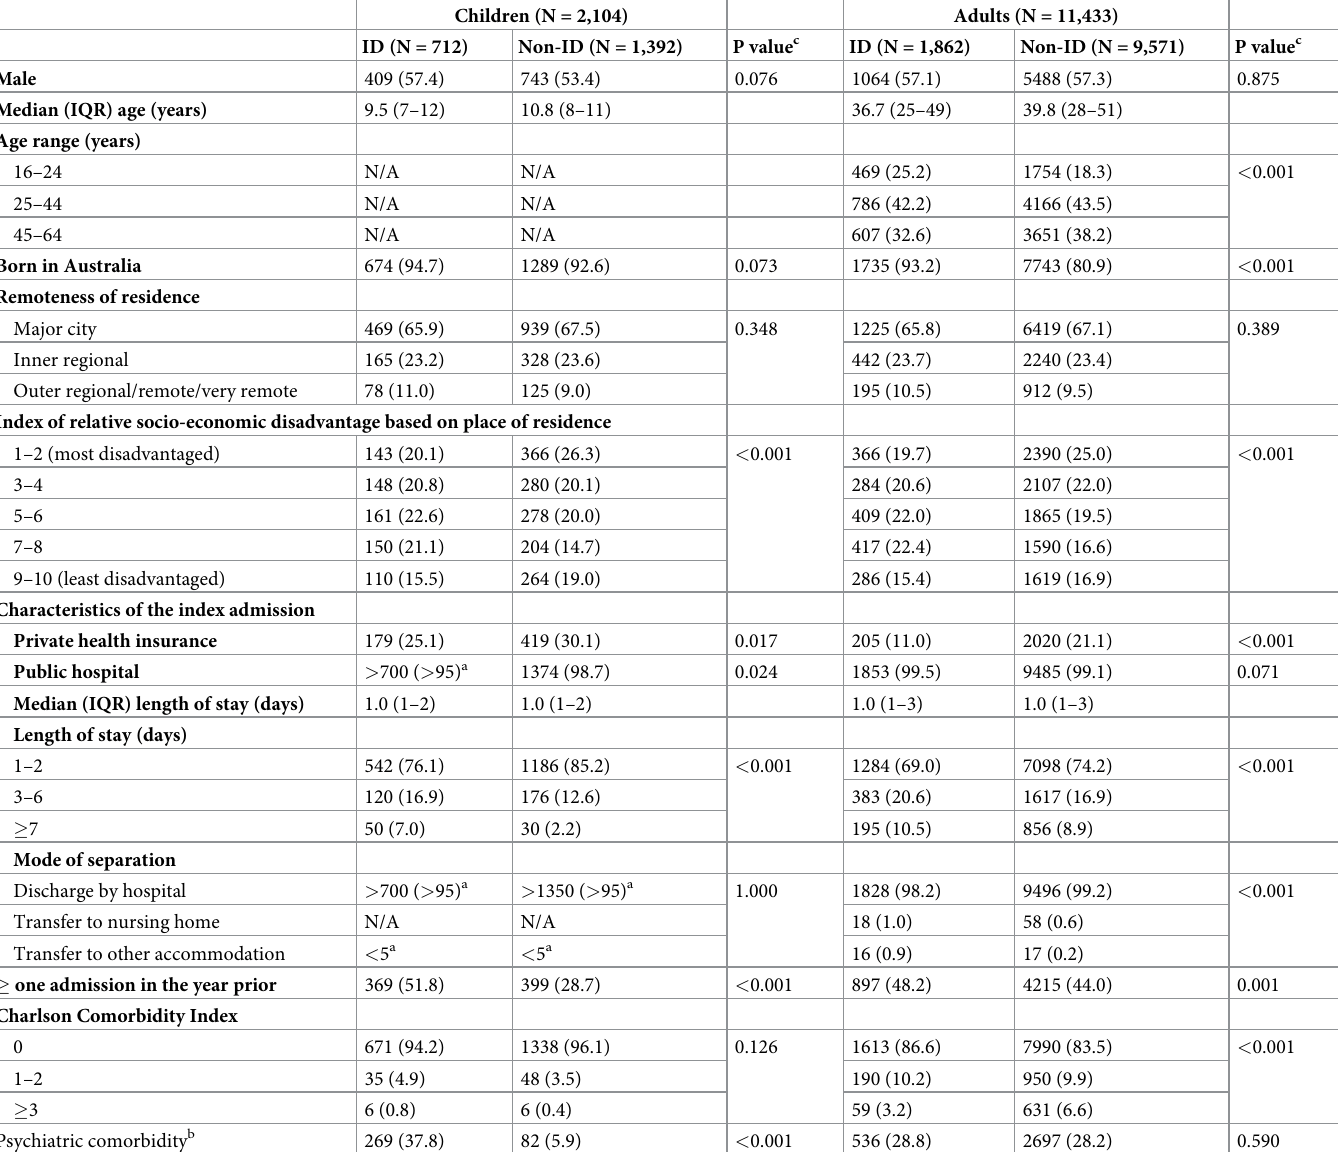
Table 1. Cohort characteristics at the index admission for children and adults with and without Intellectual disability (ID) (n,